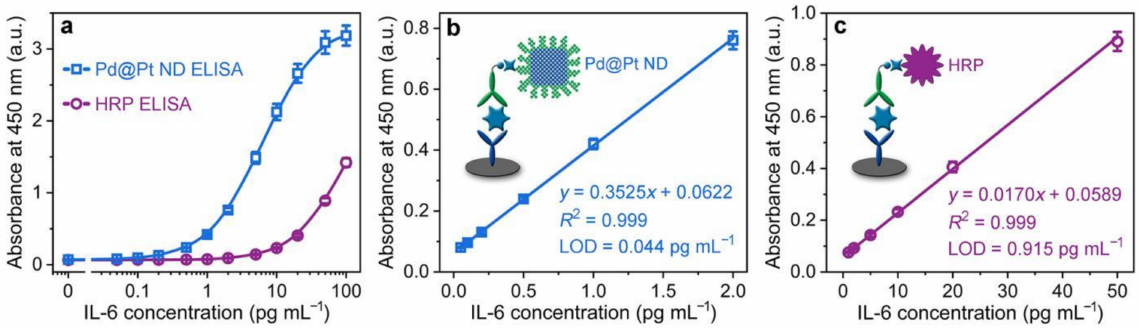
Figure 6. Detection of IL-6 standards using the colorimetric Pd@Pt ND ELISA (blue curve) and conventional HRP ELISA (violet curve). ( a ) Calibration curves of Pd@Pt ND ELISA and HRP ELISA that were generated by plotting the absorbance at 450 nm of the final detection solution against IL-6 concentration. ( b , c ) Linear range regions of the calibration curves for Pd@Pt ND ELISA ( b ) and HRP ELISA ( c